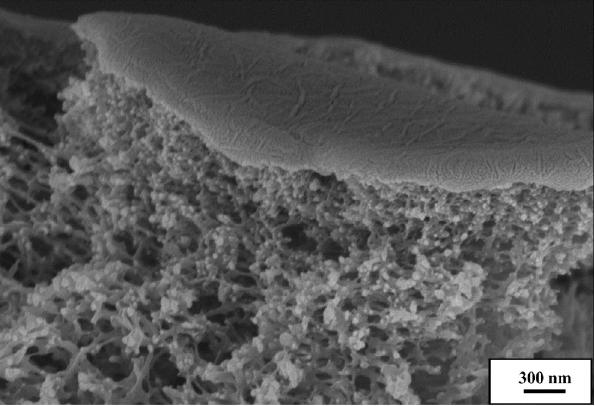
Figure 3. AFM height images of LbL multilayer films deposited on membranes. (A) Bare membrane, (B) (PDAC/PSS) 25.5 , (C) (PDAC/PSS) 25 (GO + GO − ) 10.5 , (D) (PDAC/PSS) 25 (GO + GO − ) 20.5 , and (E) (PDAC/ PSS) 25.5 (GO/GO) 40.5